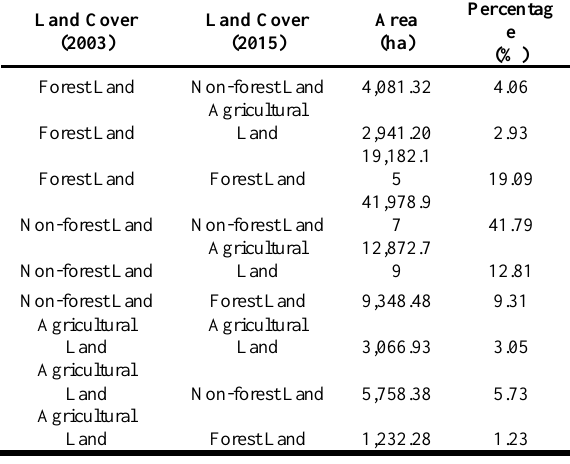
Figure 8. Thematic change map of the study area from 2003 to 2015 Table 5. Changes from one land cover type to another from the year 2003 to